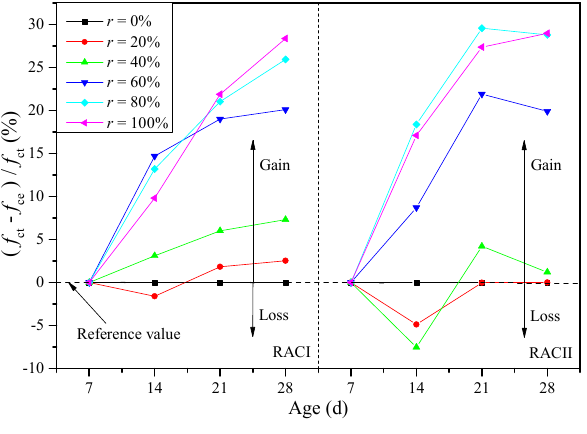
Materials 2018 , 11 , x FOR PEER REVIEW Figure 6. Internal curing proportion in each age. Figure 6. Internal curing proportion in each age.